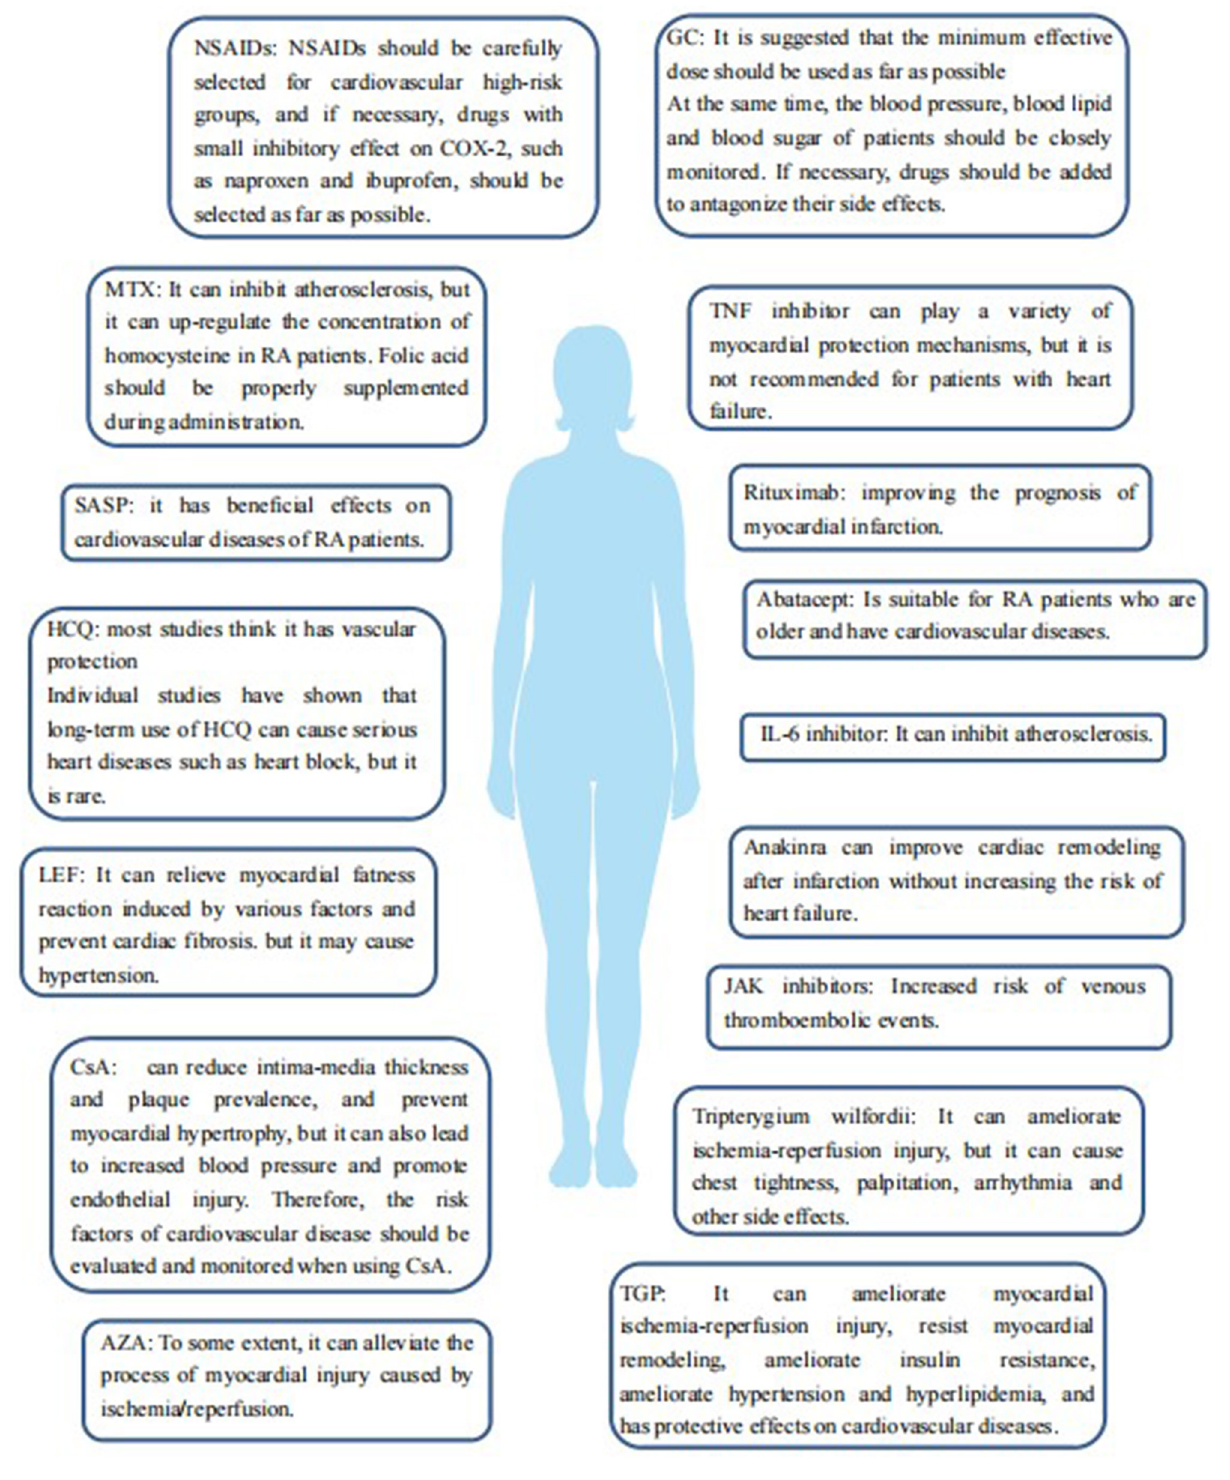
FIGURE 2 | The effect of various drugs for the treatment of RA, including NSAIDs, GCs, DMARDs, and botanicals, on cardiovascular risk in patients with RA.